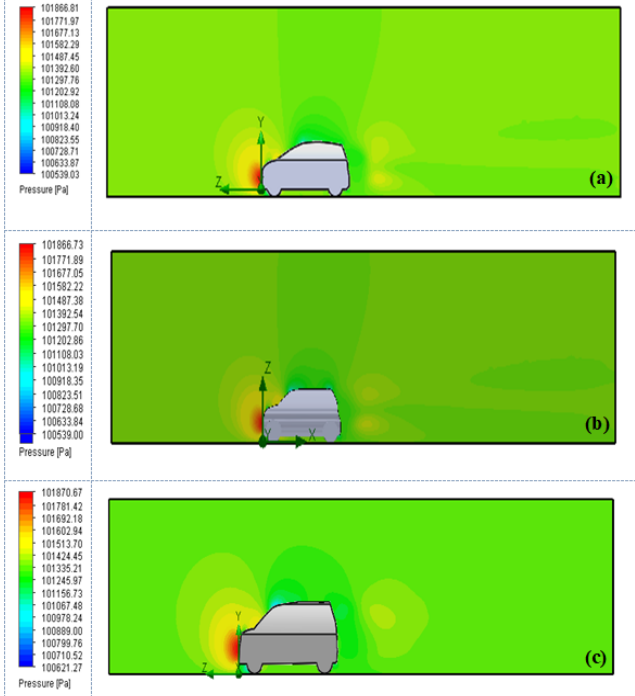
Fig. 18. Pressure contours of vehicles at 0 o diffuser angle for